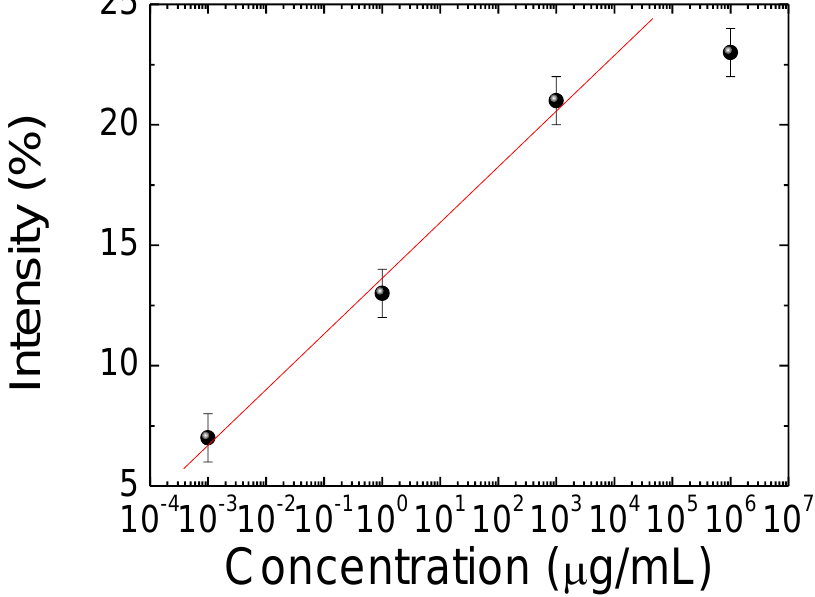
Figure 4. Linear positive correlations of the minimum transmittance of the photonic band of the cholesteric liquid crystal (CLC) biological sensor at different heme oxygenase (HO)-1 concentra- tions.